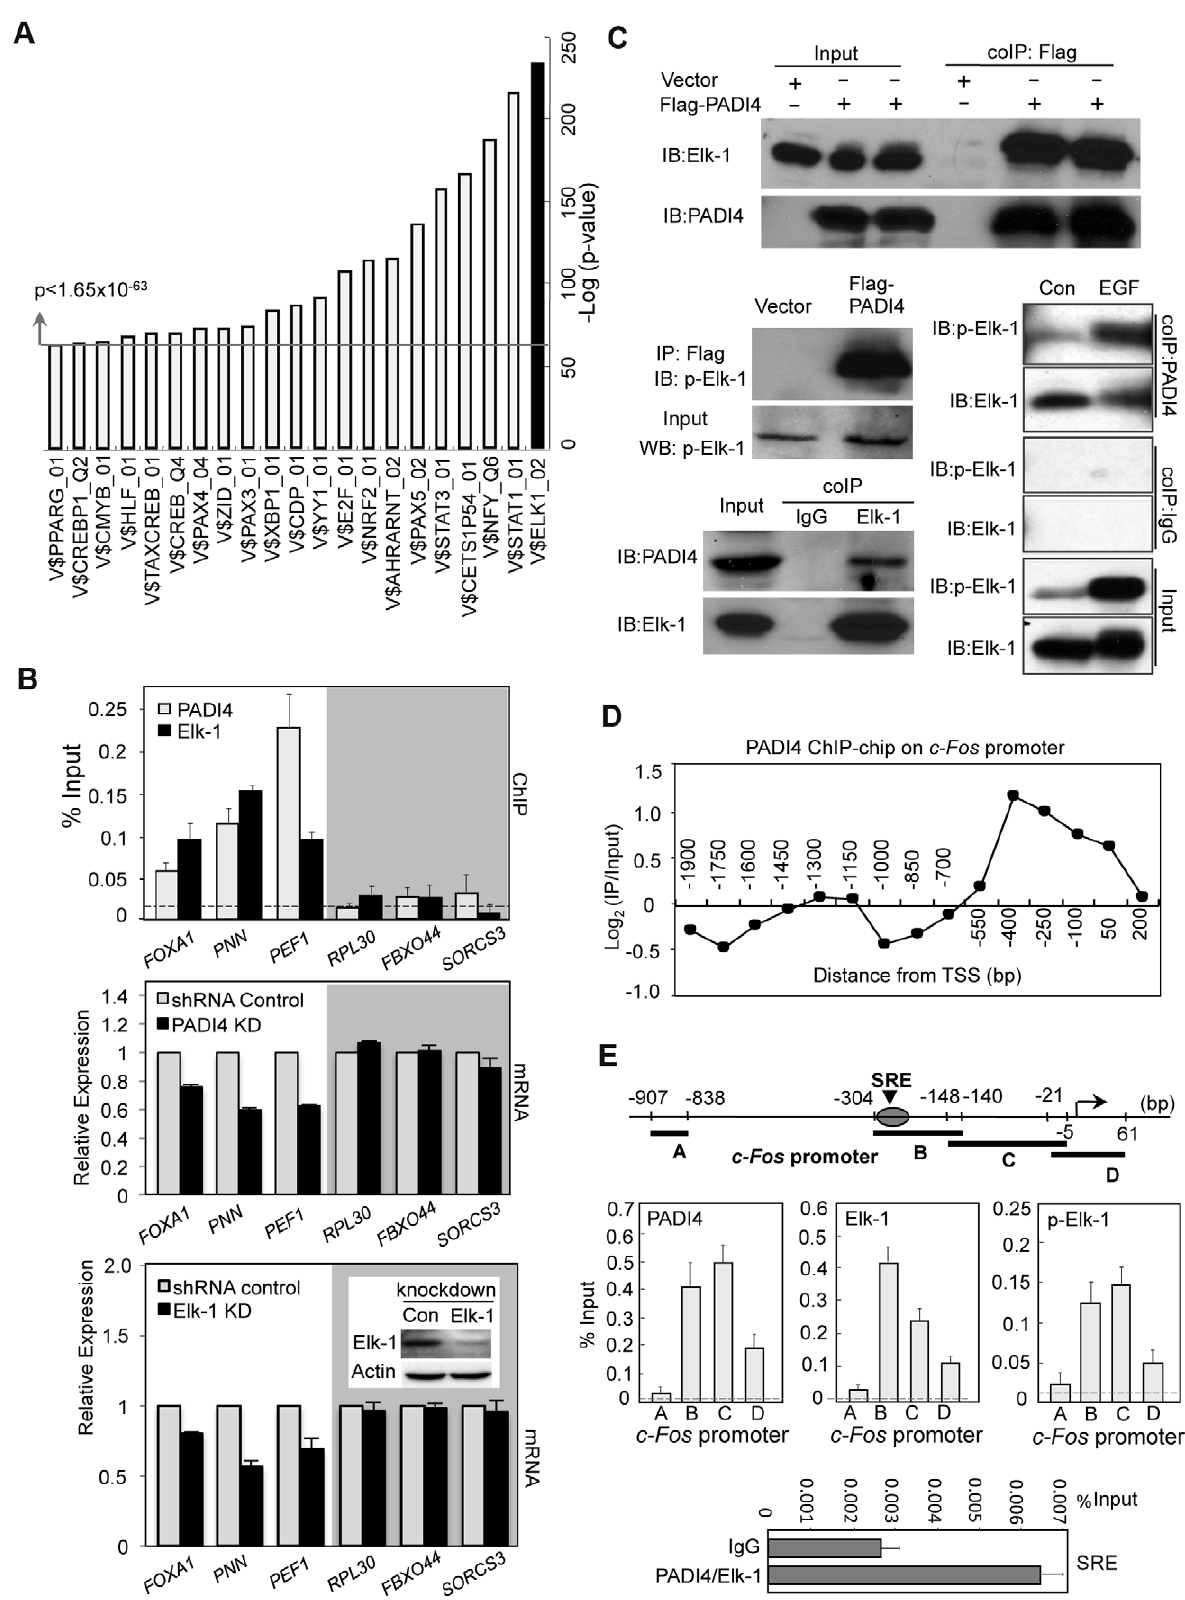
Figure 3. Co-occupancy by PADI4 and Elk-1 on a subset of Elk-1 target gene promoters. (A) Identification of enriched TFBS within the promoter regions of the significant PADI4 bound genes (p , 0.016). The bar chart displays the negative log of the enrichment P values using Fisher exact test for the top 21 motifs. The most significant V $ ELK1_02 is shown on the right in black. (B) Gene-specific analysis of promoter binding by